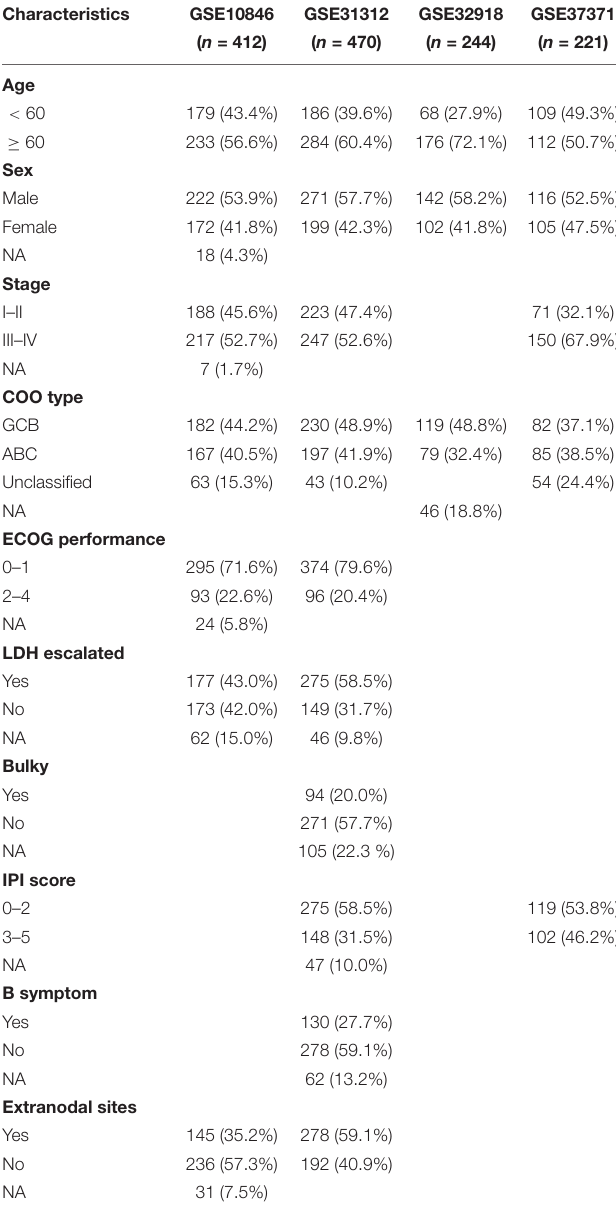
TABLE 1 | Clinical characteristics of the 1,347 cases of diffuse large B-cell lymphoma patients.